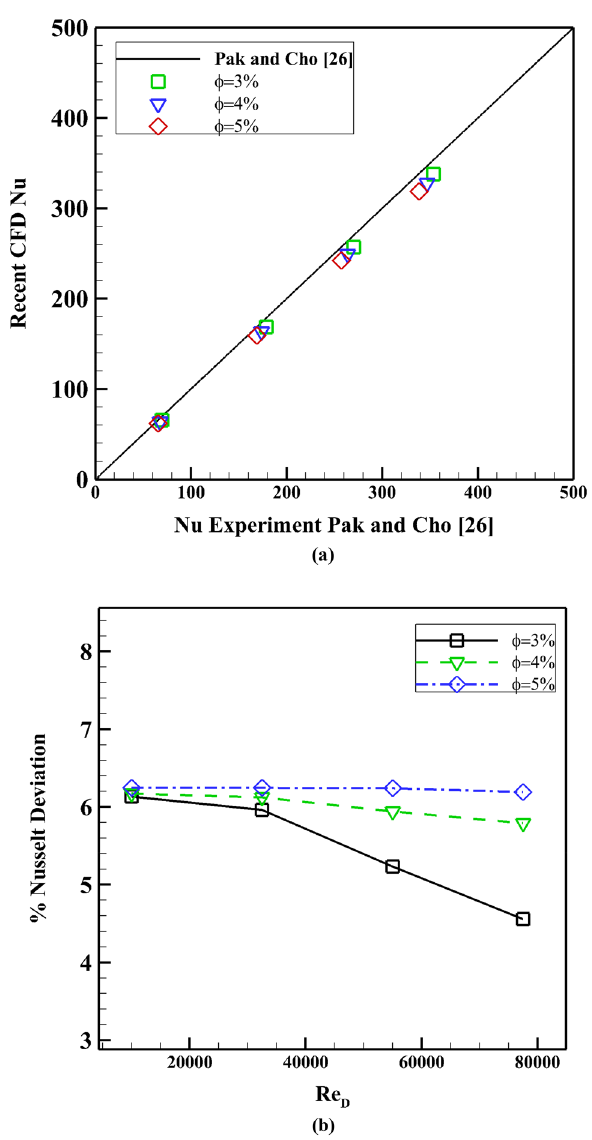
Fig. 11 Comparative Nusselt number ( a ) and Nusselt deviation ( b ) with experimental correlation Pak and Cho [26]